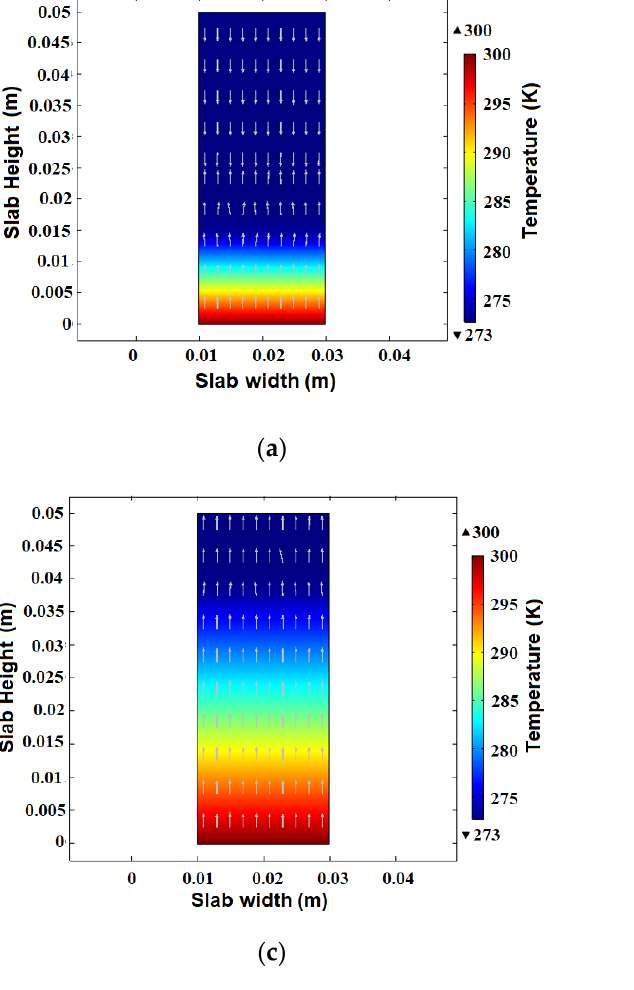
temperature interval, rather than a sharp melting point. The plot shows a good coincidence of the heat capacity profile and its peak at different times and